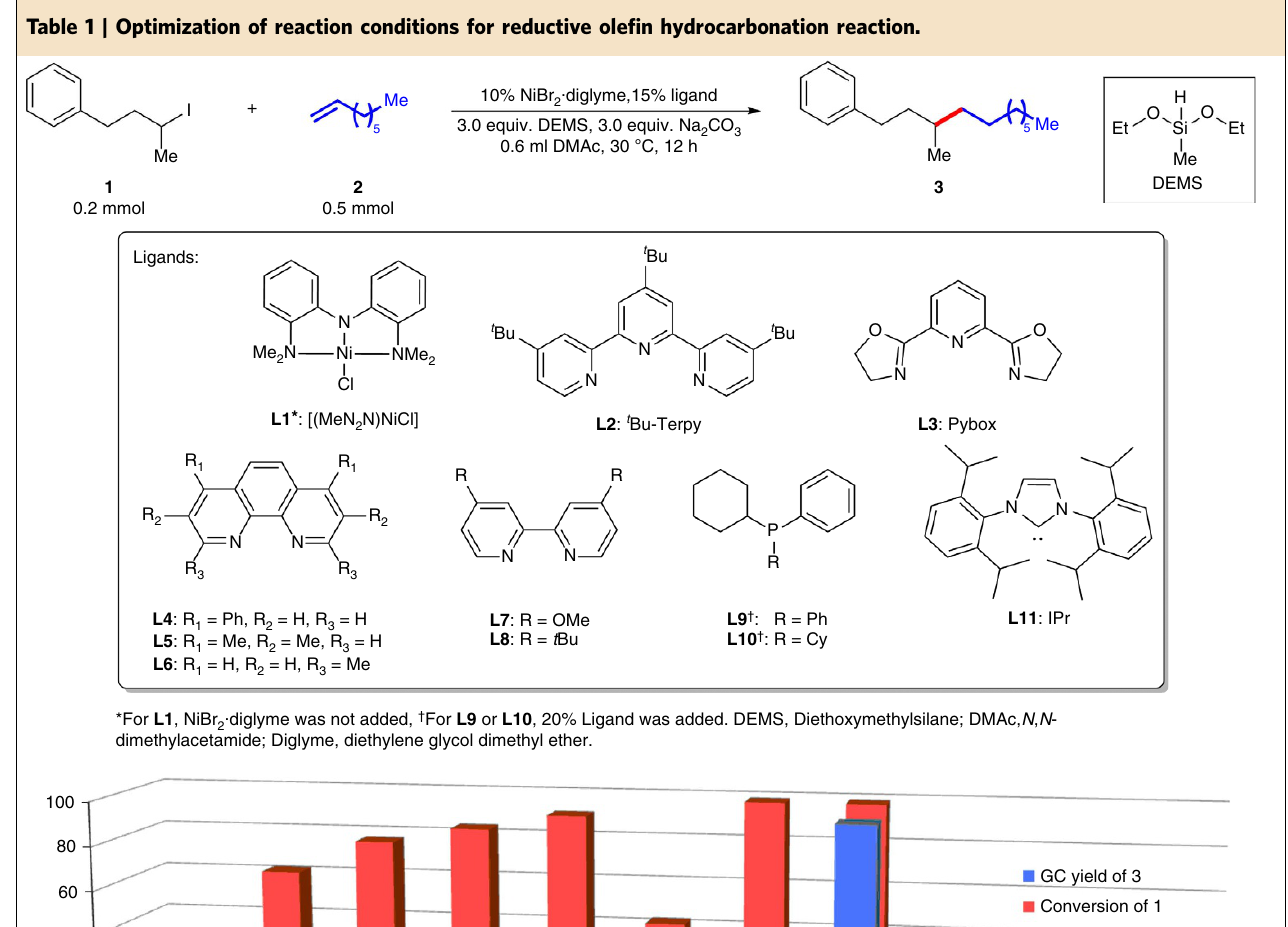
Table 1 | Optimization of reaction conditions for reductive olefin hydrocarbonation reaction.